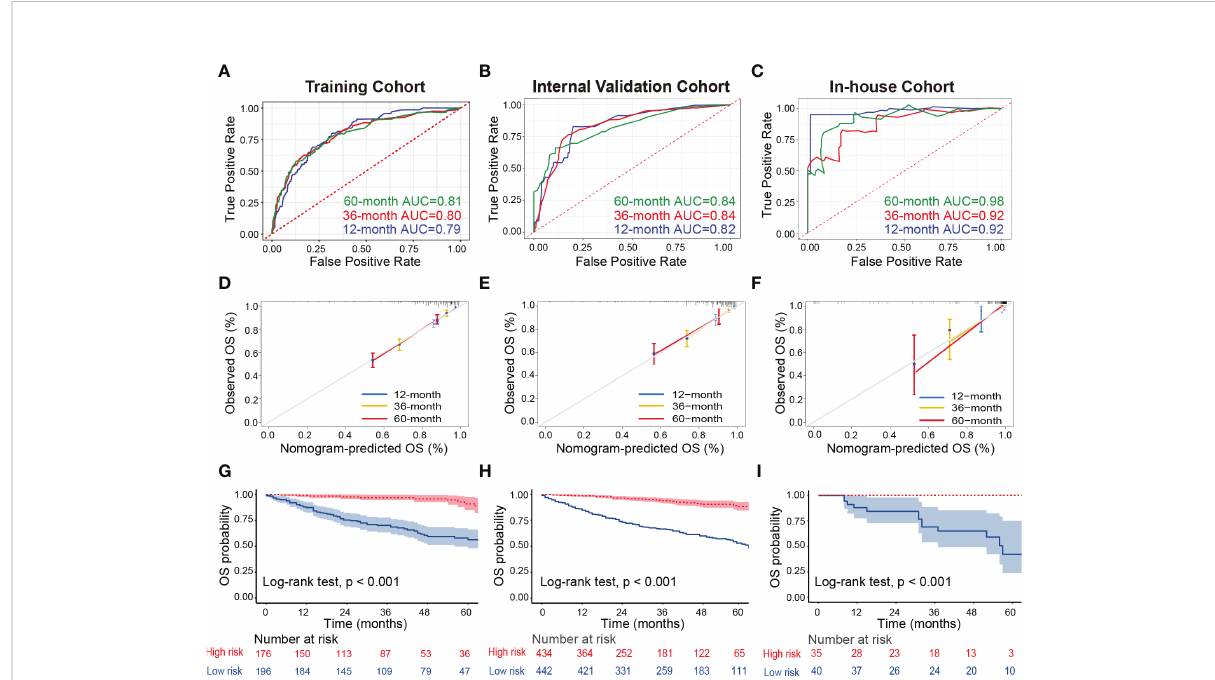
FIGURE 3 Assessment of the discrimination and calibration abilities of the constructed nomogram. (A – C) The ROC curves for predicting 12-, 36-, and 60- month OS of patients with TETs in the training cohort (A) , internal validation cohort (B) , and in-house cohort (C) based on the nomogram. (D – F) The calibration curves for predicting 12-, 36-, and 60-month OS of patients with TETs in the training cohort (D) , internal validation cohort (E) , and in-house cohort (F) are based on the nomogram. (G – I) Kaplan-Meier survival curves to display the risk strati fi cation ability of the nomogram in the training cohort (G) , internal validation cohort (H) , and in-house cohort (I) . ROC, receiver operating characteristic curves; TETs, thymic epithelial tumors; OS, overall